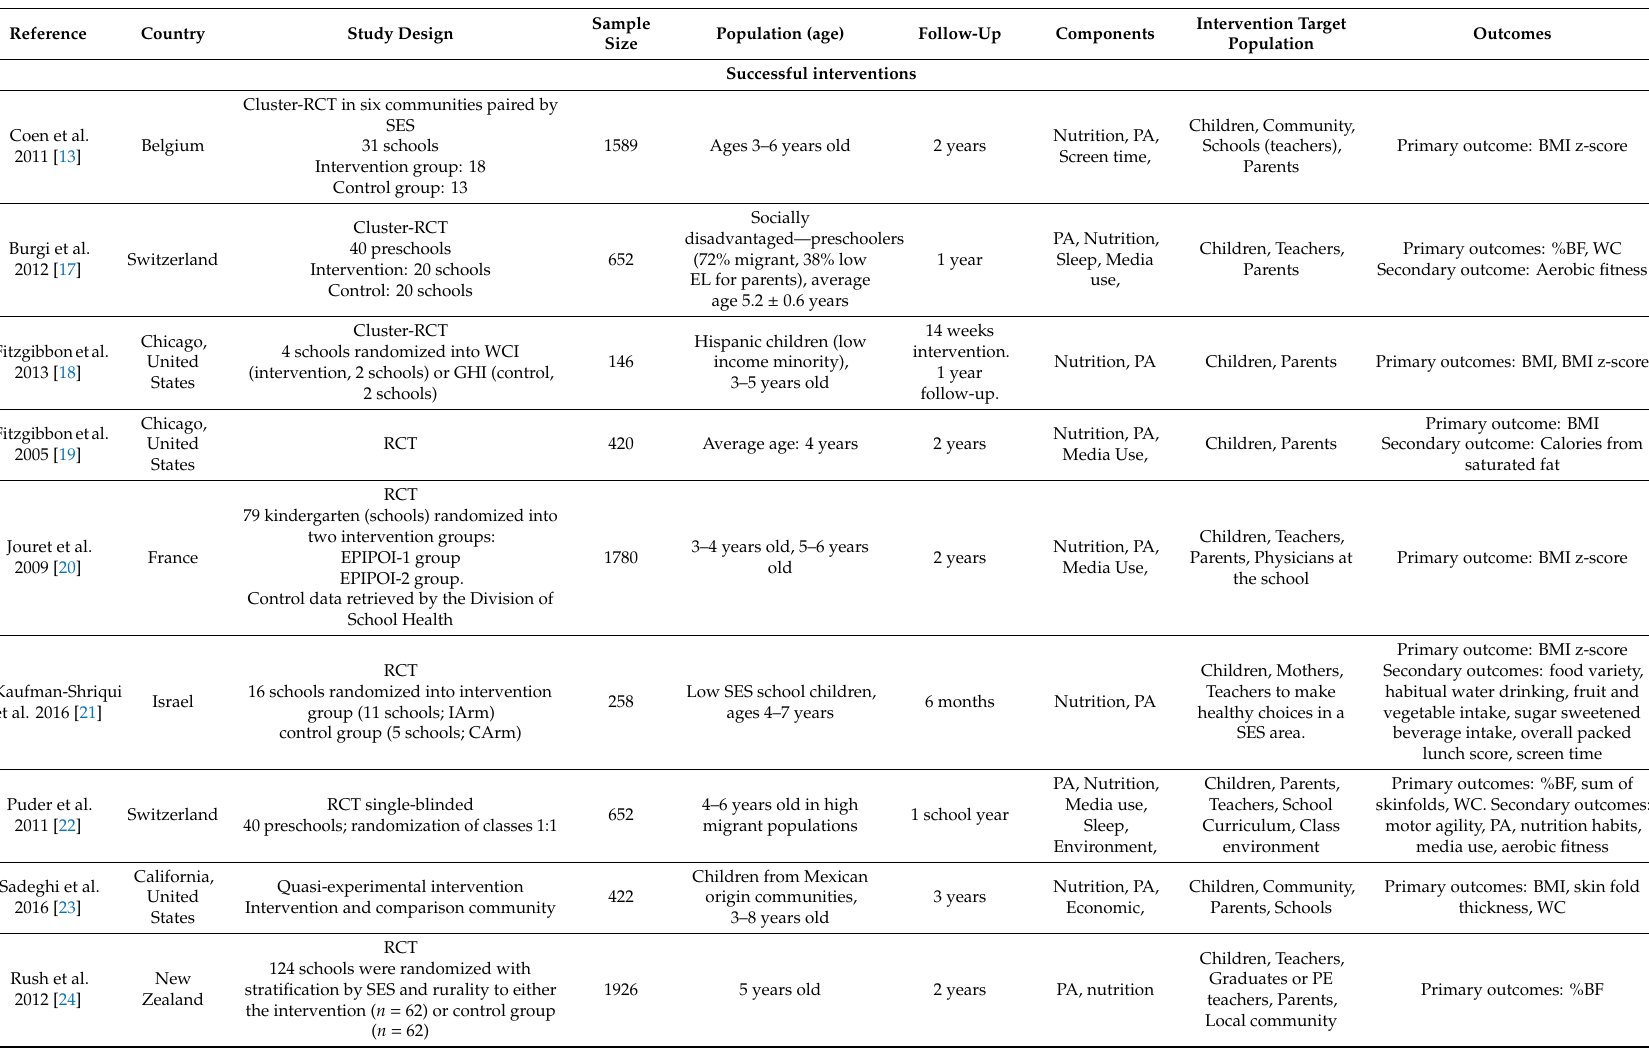
Table 1. Summary of studies evaluating school-based interventions among preschoolers in low socioeconomic status (SES) settings to tackle pediatric obesity.